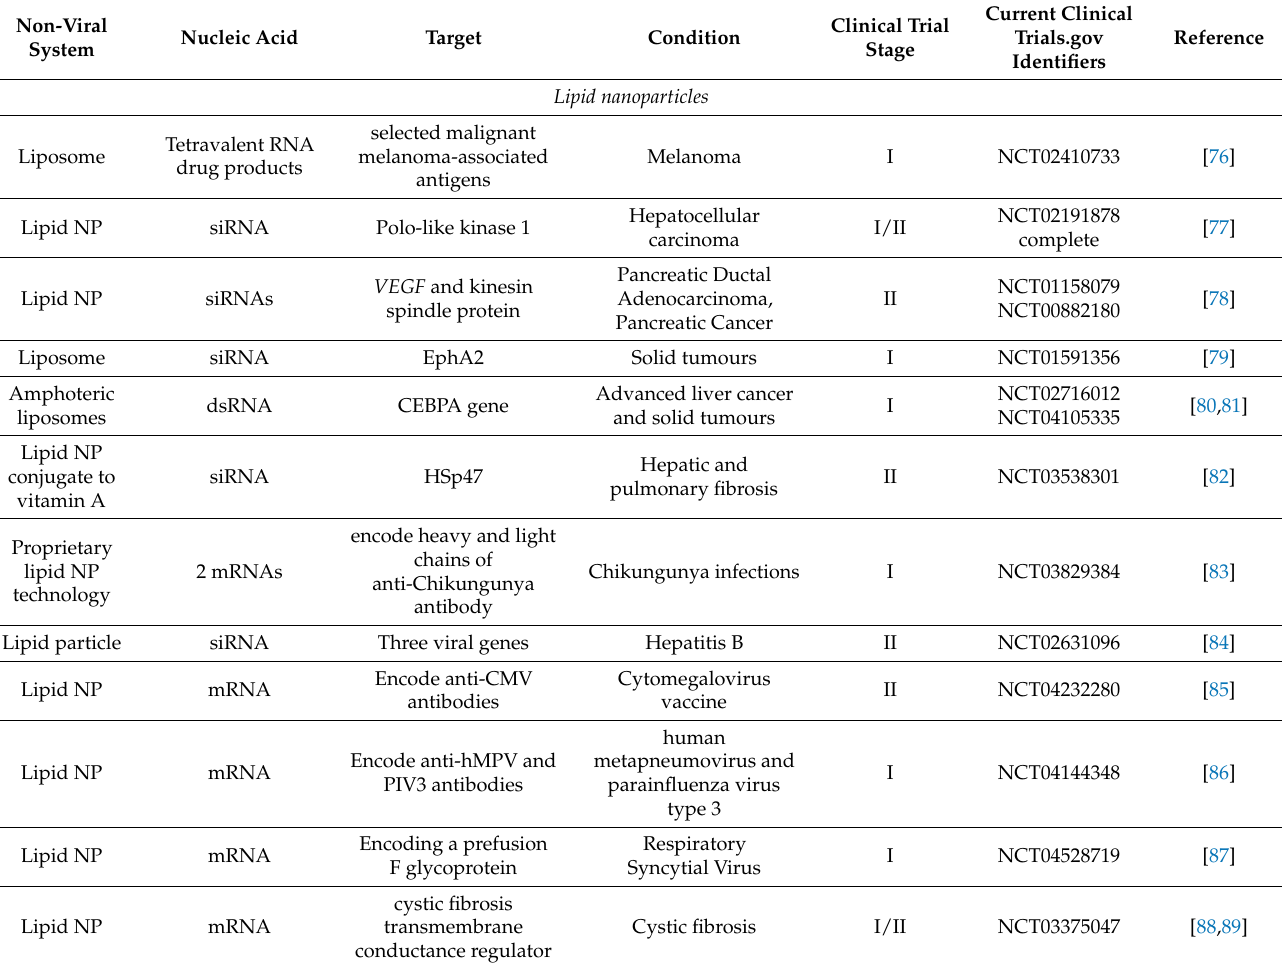
Table 1. Selected non-viral systems used for delivery of RNA therapeutics in clinical trials and pre-clinical